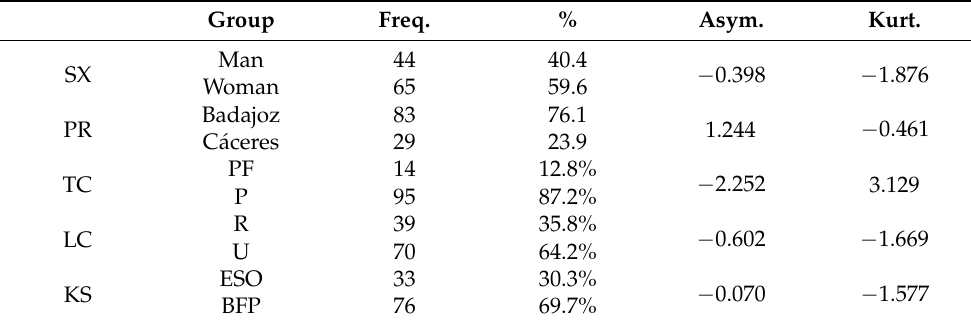
Table 3. Nominal